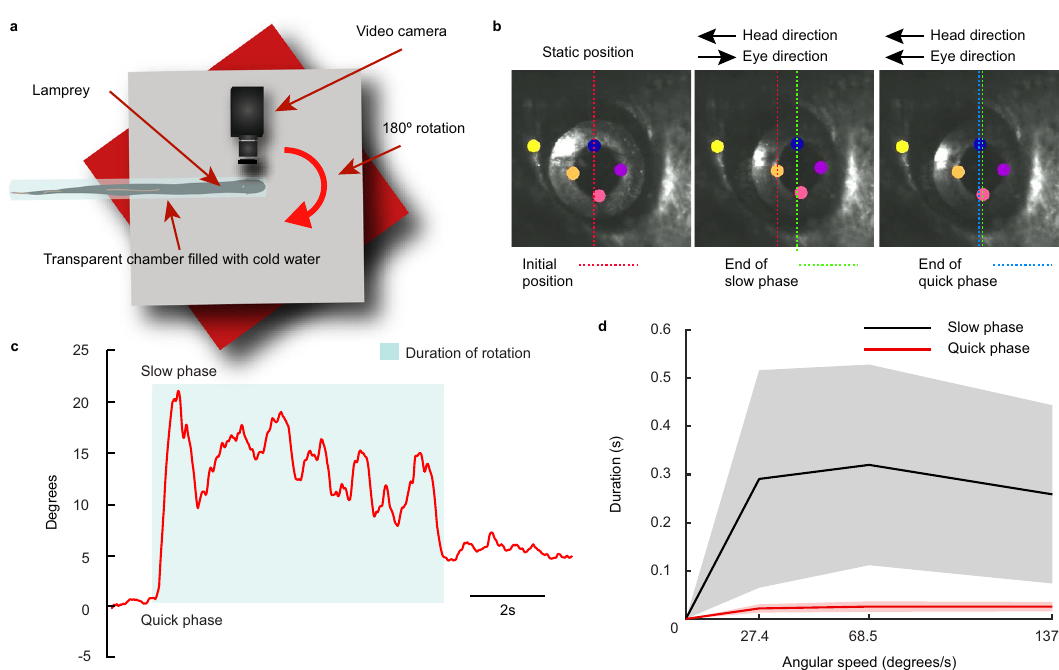
Fig. 8 | VOR nystagmus. a Our in-lab built platform allowed for controlled rota- tions of intact lampreys in the yaw plane. Animals were encased in a transparent plastic tube fi lled with cold fresh water. The diameter of the cylinder allowed for breathingwhilelimitingtheanimal ’ sfreedomofmovement.Acamerawasattached to the platform so that one eye could be fi lmed during the stimulation, which consisted in 180° rotations at different speeds. b Lamprey eye positions were quanti fi ed using DeepLabCut, which allowed for identifying movements of the pupil(fourlabels wereusedto average,indicated inorange, blue, purpleand pink) inreferencetothehead(yellow).Thereddottedlinerepresentseyepositionatthe start of the yaw stimulation (static position), while the green line indicates the end position of the slow (compensatory) phase result of a movement in opposite directiontothatofthehead.Thebluelineindicatestheendpositionoftheeyeafter the following quick phase (resetting) eye movement in the same direction as the